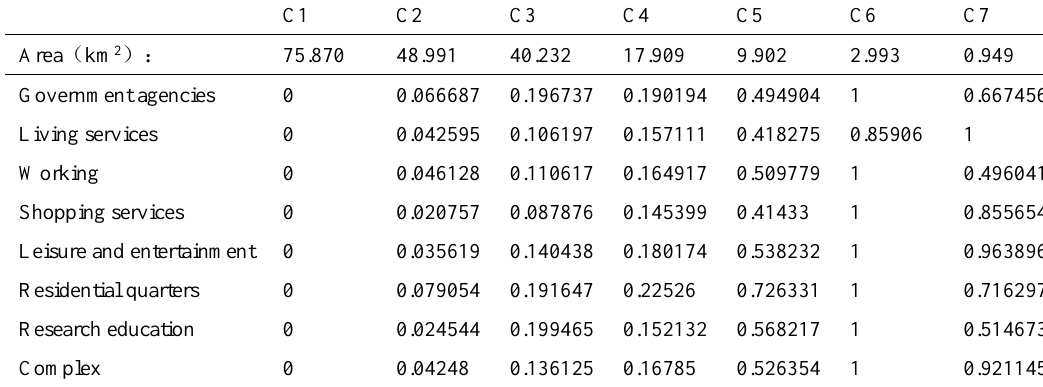
Table 5. POI standardized values of various plots (22: 00 ~ 24: 00 O)